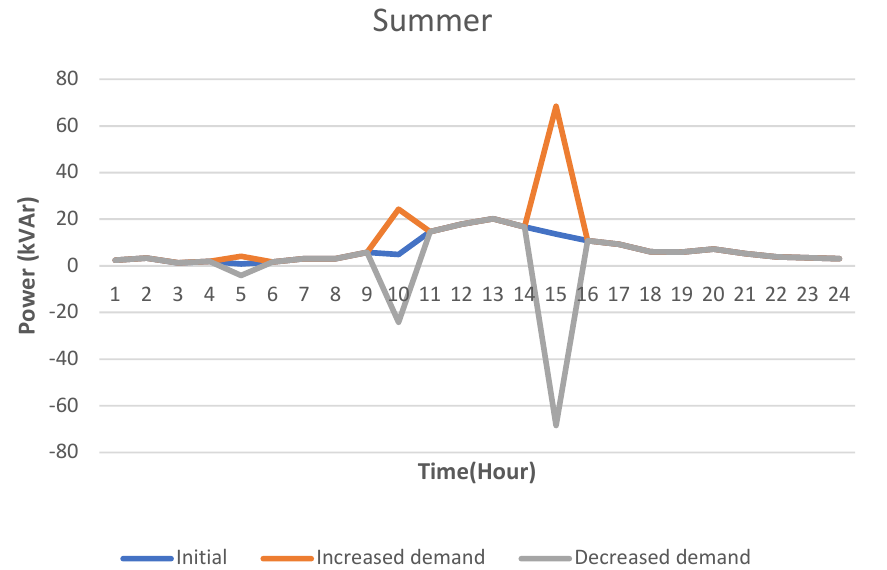
Figure 19. The reactive power provided by smart inverters in summer when demand varies.